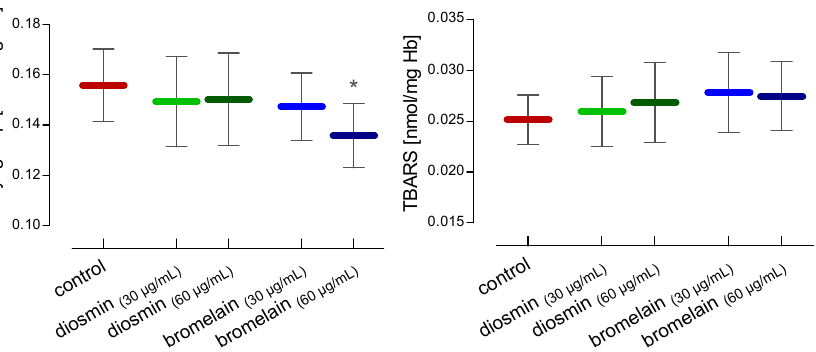
Figure 1. Alterations in carbonyl group and TBARS concentrations in RBCs after 24 h of incubation with diosmin or bromelain. The data were expressed as mean ± standard deviation, n = 16. Statistical significance: * p < 0.05 vs. control.